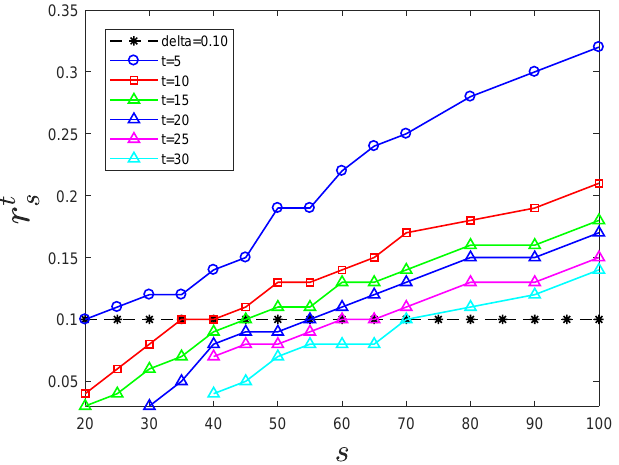
Figure 2. The accuracy increase of different t unknown subclasses compared with the original